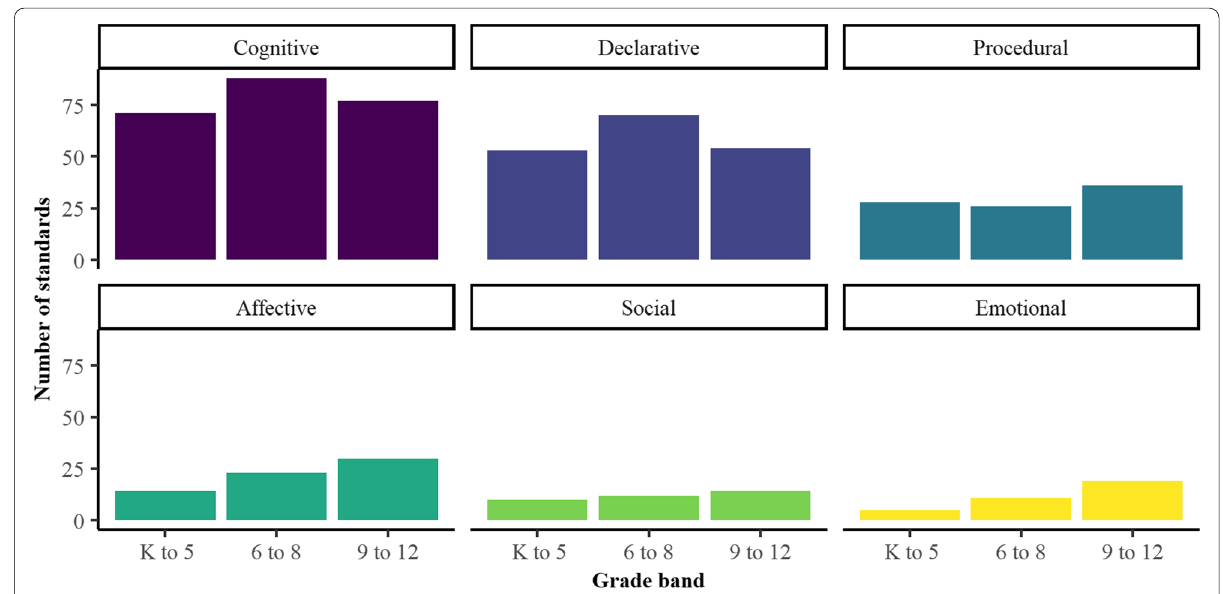
Fig. 4 Water‑related standards representation of learning domains across grade bands (K‑12)